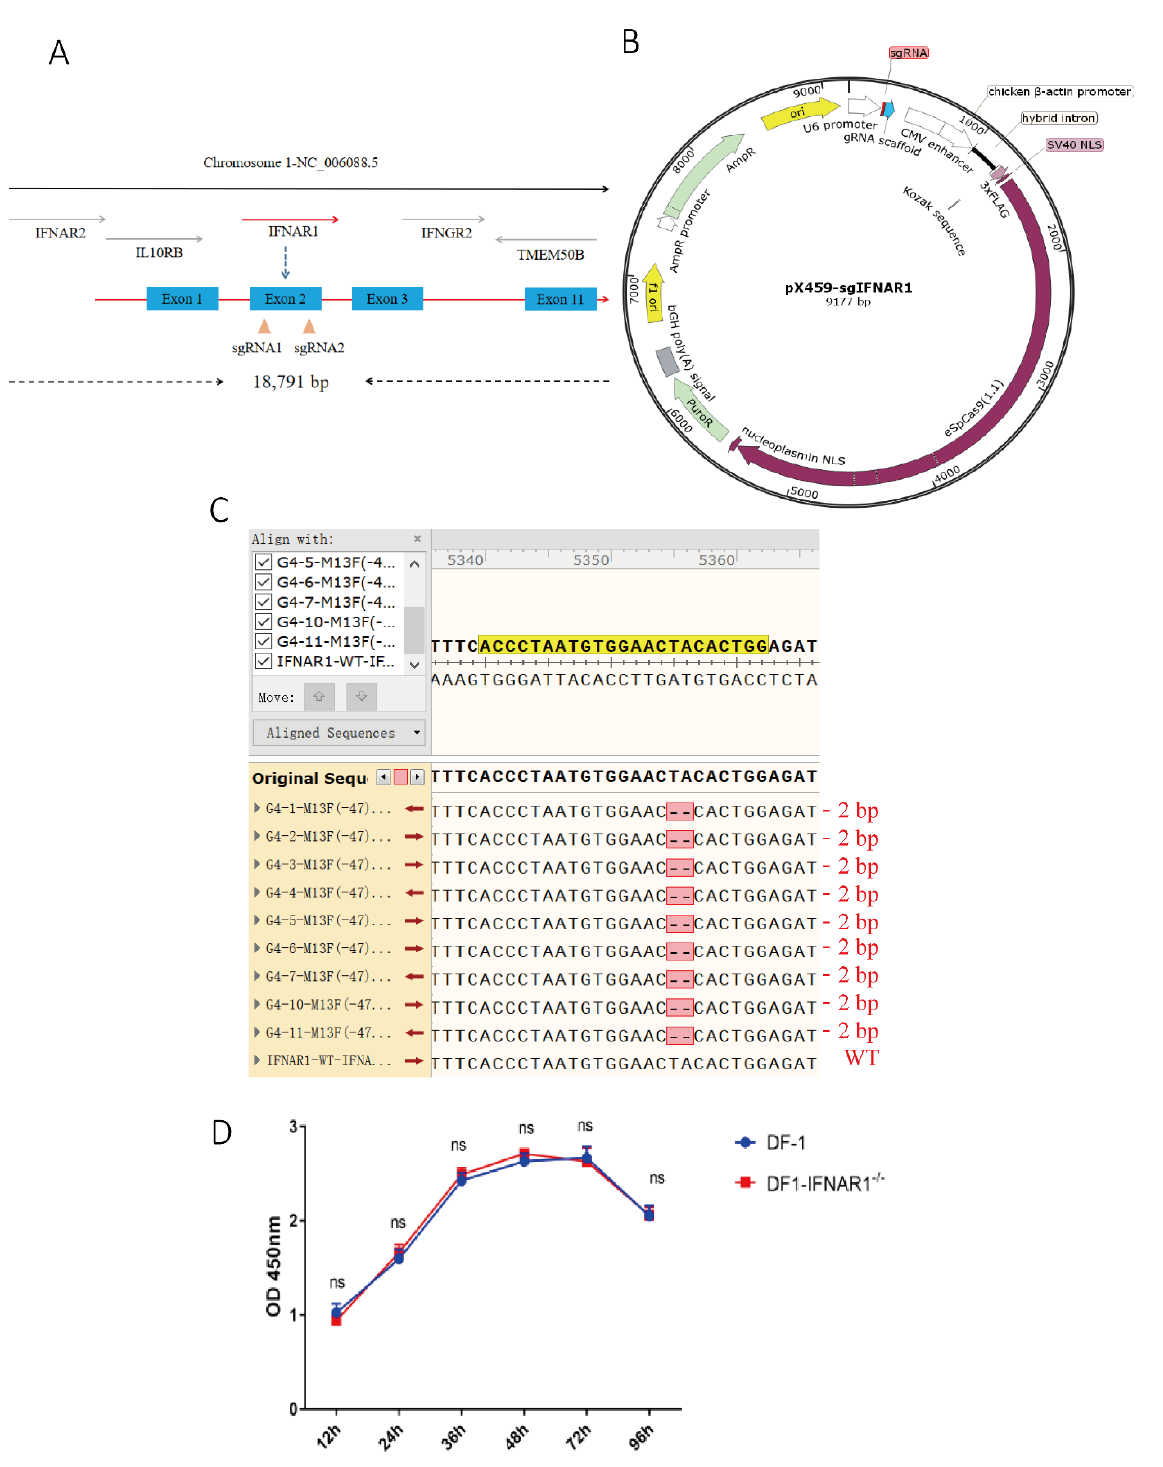
Figure 1. Construction of KO-IFNAR1 cell line. ( A ) Schematic diagram of chIFNAR1 gene and target sites. The two target sites were designed based on the sequence of exon 1. ( B ) Schematic diagram of the pX459 vector used for gene knockout in this study. ( C ) Sequencing results of targeting regions in KO-IFNAR1 monoclonal cells. Sequence alignment in-between revealed a homozygous 2 bp-deletion in KO-IFNAR1 cells. ( D ) Proliferation of KO-IFNAR1 cell line using CCK8 assay. ns, non- significant.